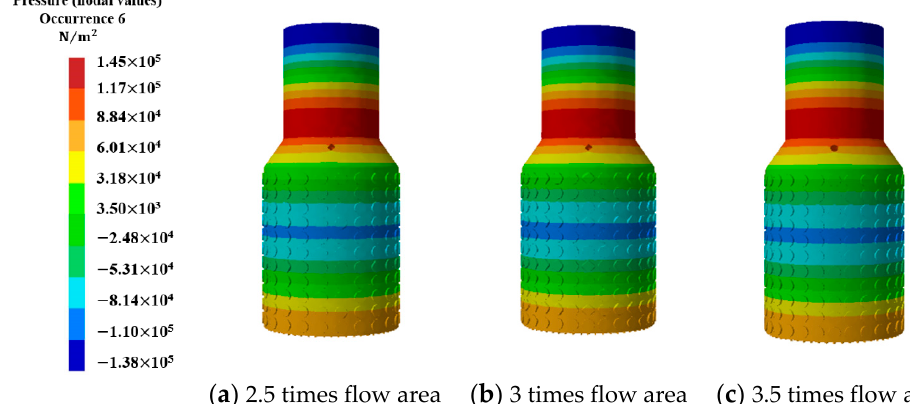
Figure 25. Sixth-order acoustic cavity modality.